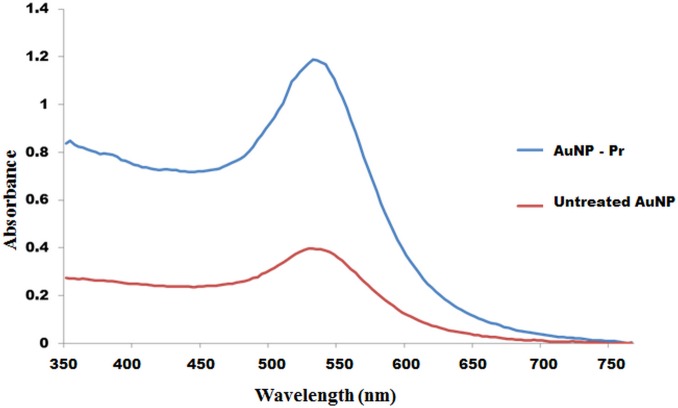
Comparison of absorption spectra of colloidal AuNP and of the DNA-labelled AuNP probe.